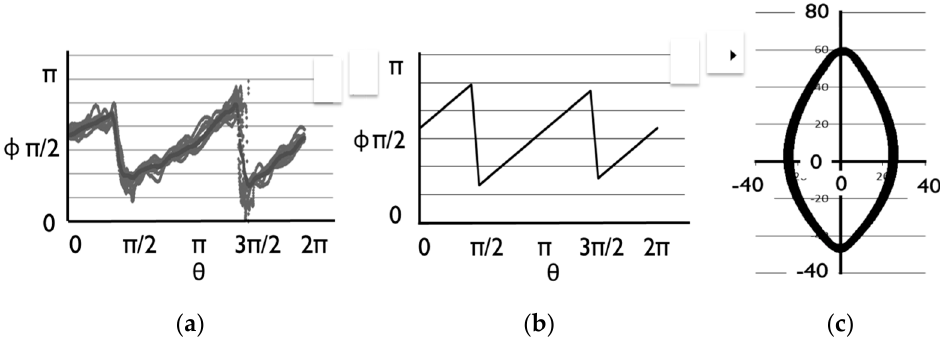
Figure 16 . Transformation of leaves: ( a ) Transformed data; ( b ) Average of bundle; ( c ) Inverse transformation.